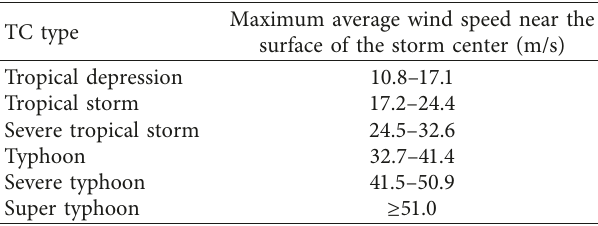
Table 1: TC intensity levels as defined by the CMA. Maximum average wind speed near the TC type surface of the storm center